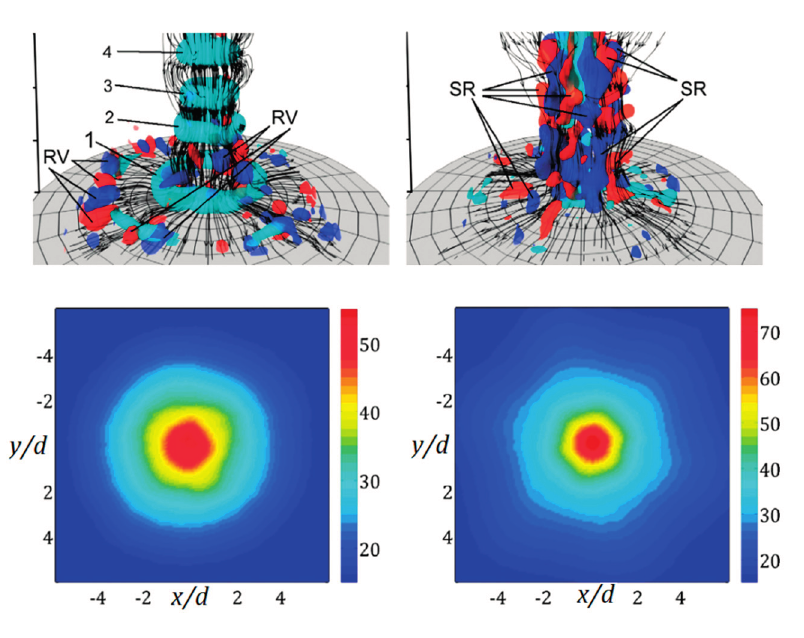
Figure 26. Instantaneous flow patterns ( top ) and Nusselt number distributions on the impinging plate ( bottom ) for a cylindrical ( left ) and a chevron ( right ) nozzle; Re = 5000, z/D = 4; RV radial vortices, SR streamwise structures. Adapted from Violato et al .